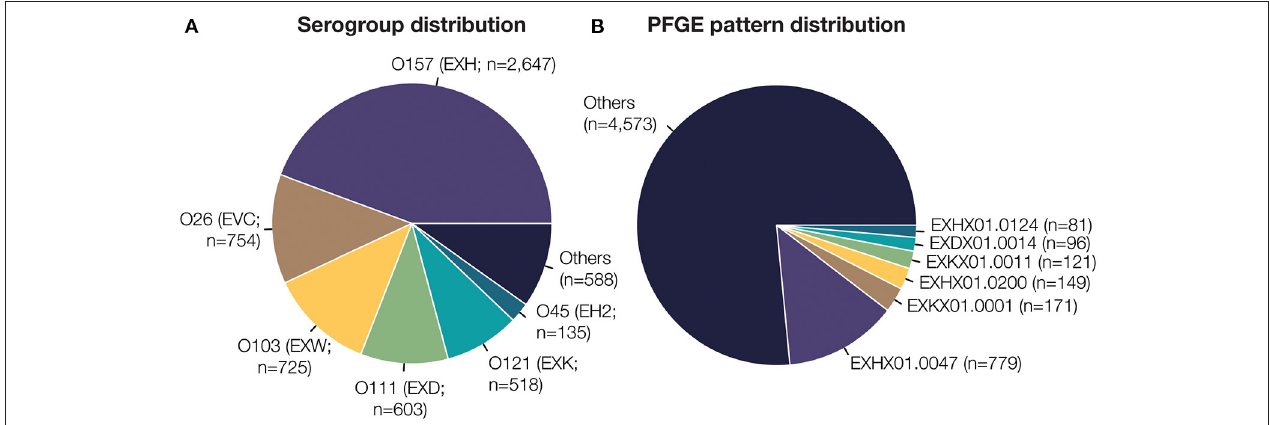
FIGURE 1 | Dataset composition of 5,970 E. coli isolate whole genome sequences. (A) Serotype is designated by the O-antigen serogroup and 3-letter identifier assigned by PulseNet (denoted in parentheses). The six most frequent E. coli O-antigen serogroups are highlighted. (B) PFGE pattern identifiers are prefixed by the 3-letter serotype. The six most frequent unique PFGE patterns are highlighted here. In total, 27 unique E. coli O-serogroups and 377 unique PFGE patterns are present in the dataset used to train and test our classification model.